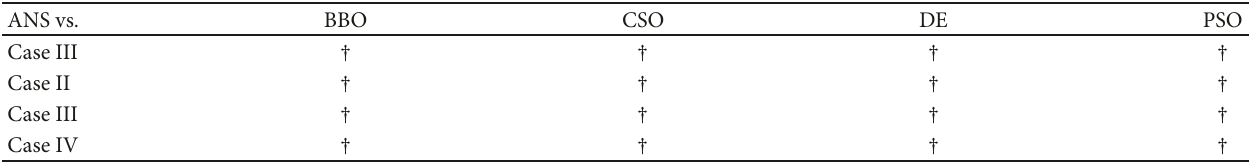
Table 10: Statistical analysis results based on Wilcoxon’s rank sum